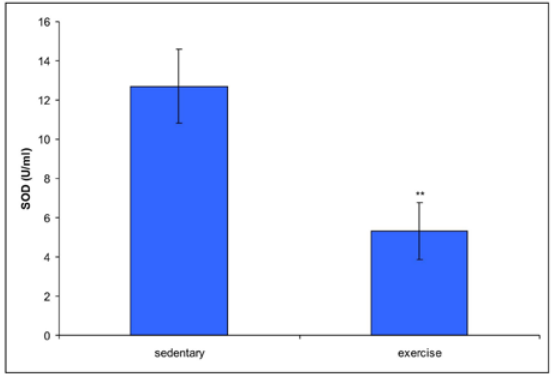
Figure 1. The effects of five minutes treadmill exercise on SOD specific activity from the rat serum. The values are mean ±